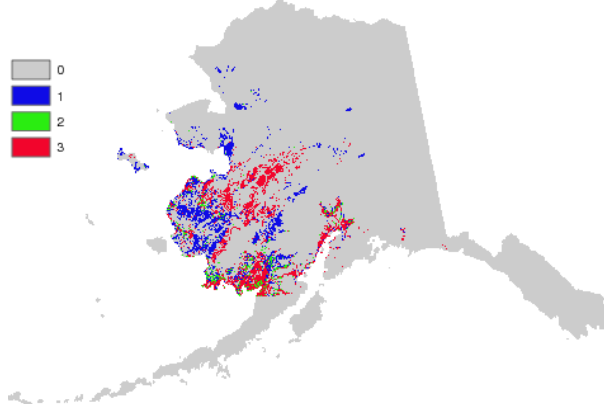
Fig. 9. Additional organic layer map obtained after model tuning. 0 – no additional organic; 1 – one additional layer of organic matter (5cm); 2 – two additional layers of organic matter ( 10cm); 3 – three additional layers of organic matter (27cm).